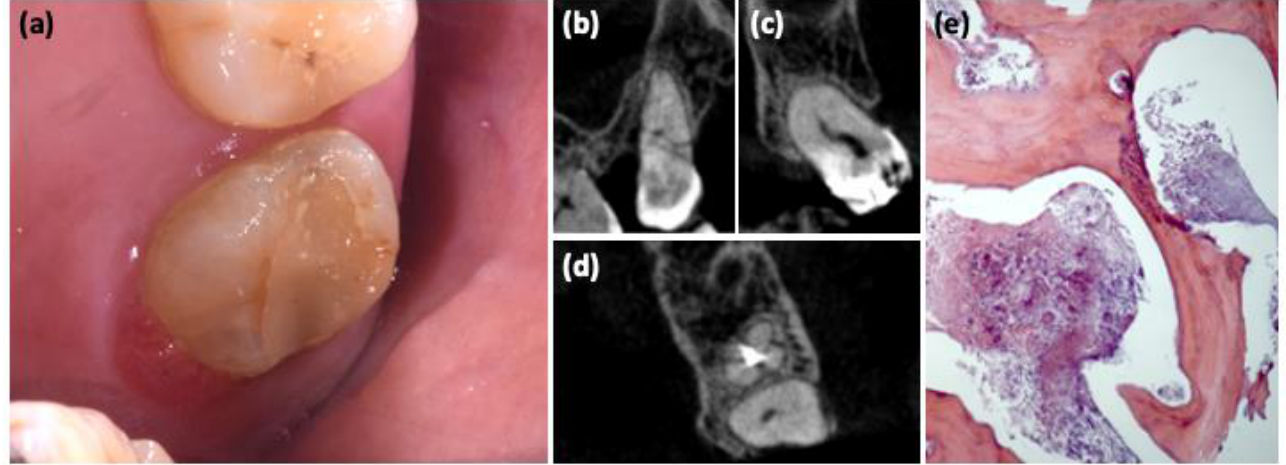
Figure 3. MRONJ stage I, upper jaw: ( a ) clinical view; ( b – d ) computed tomography scan sections; ( e ) magnification of histological findings.